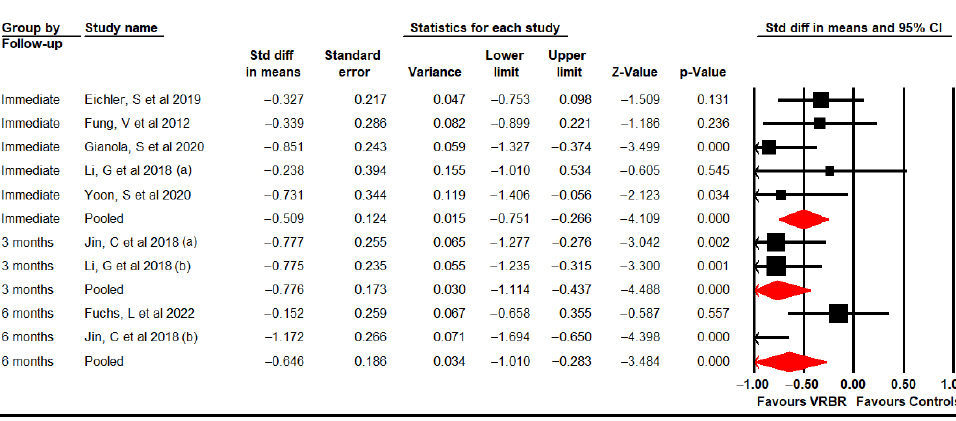
Figure 3. Forest plot of the immediate effect of VRBR on knee function [61–67].